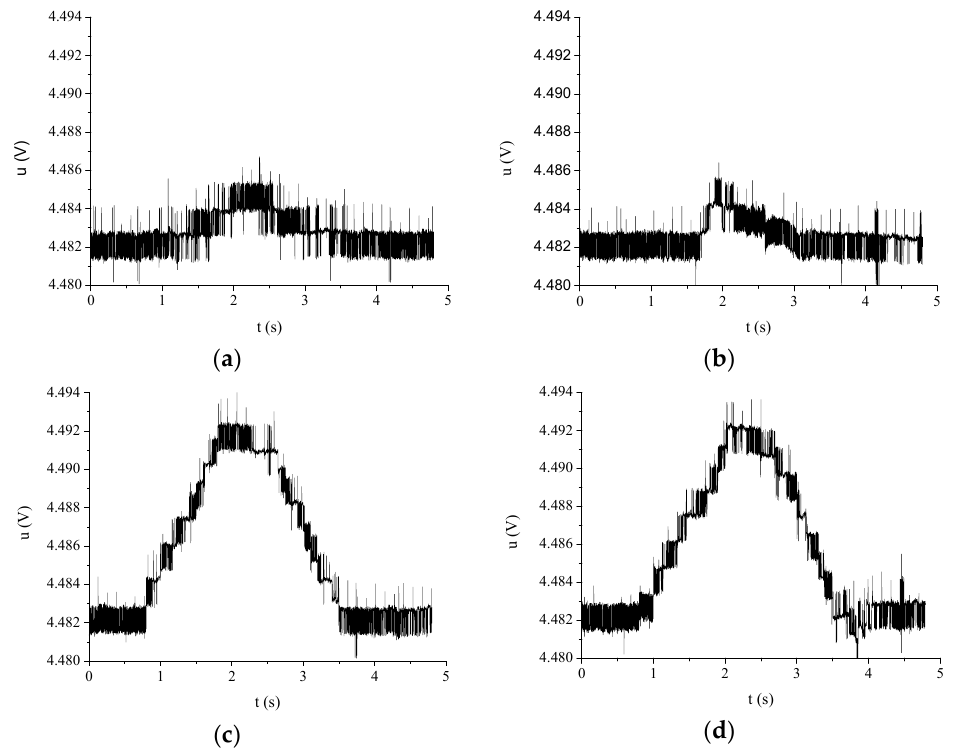
Figure 4. Waveforms of tactile voltage signals: ( a ) contact between the gasbag and weeds; ( b ) contact between the gasbag end and rice; ( c ) contact between the middle of the gasbag and rice; and ( d ) contact between the root of the gasbag end and rice.